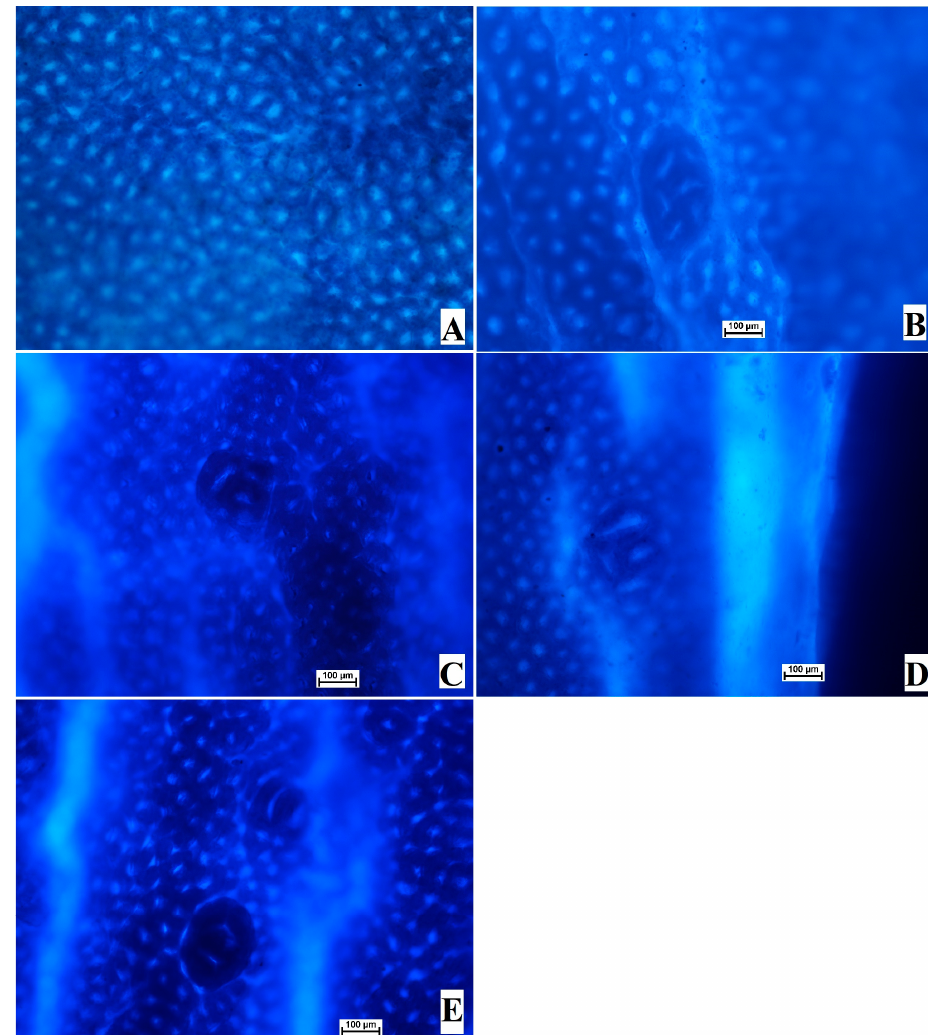
Figure 2. Influence of OME on the gross views of foci in the mucosal colon from experimental rats and with the methylene blue stain. ( A ), normal control; ( B ), cancer control (rats addressed with only AOM); ( C ), reference (rats administered 35 mg/kg of 5-FU); ( D ), low-dose OME (rats administered 200 mg/kg of OME); ( E ), High-dose OME (rats addressed with 400 mg/kg of OME). Aberrant crypts were distinguished from normal crypts by their larger size, their higher distance area between basal cell to the surface lumina, and their observable pericryptal region (methylene blue stain; 10× magnification).